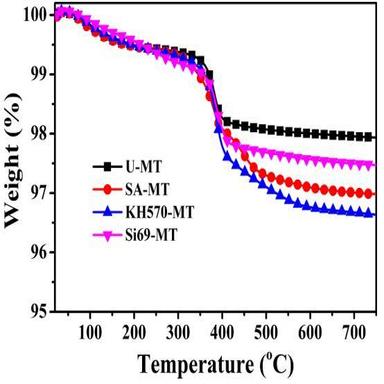
TG curves of untreated and modified MT particles.